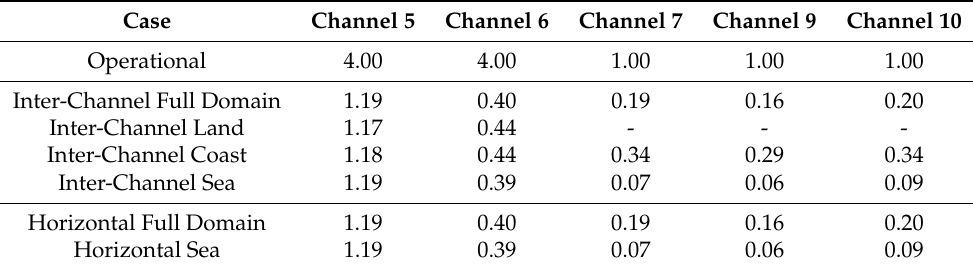
Table 2. SEVIRI Observation error